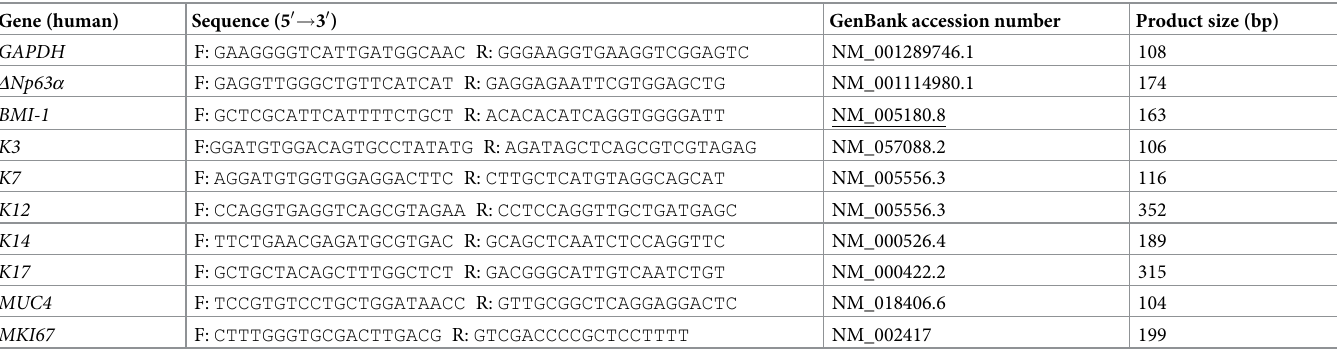
Table 1. Primers used for quantitative real-time